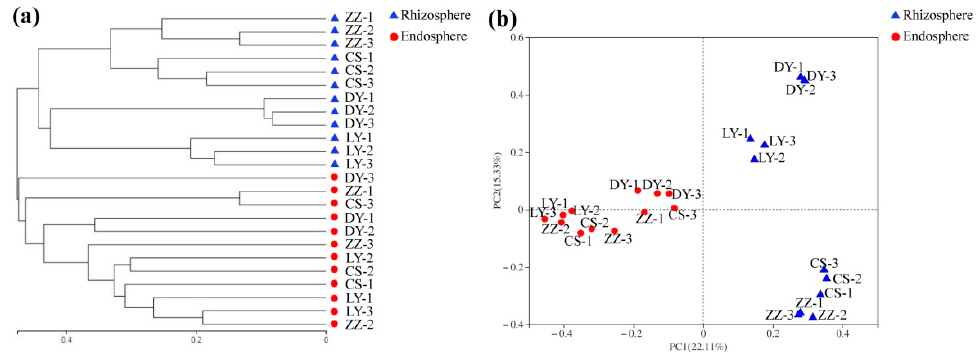
Figure 2. Microbial community differentiation in the endosphere and rhizosphere of C . communis . ( a ) Hierarchical clustering of the bacterial communities based on the Bray–Curtis dissimilarity of all of the samples. ( b ) Principal coordinate analysis (PCoA) of the bacterial communities based on the Bray–Curtis distances between samples.